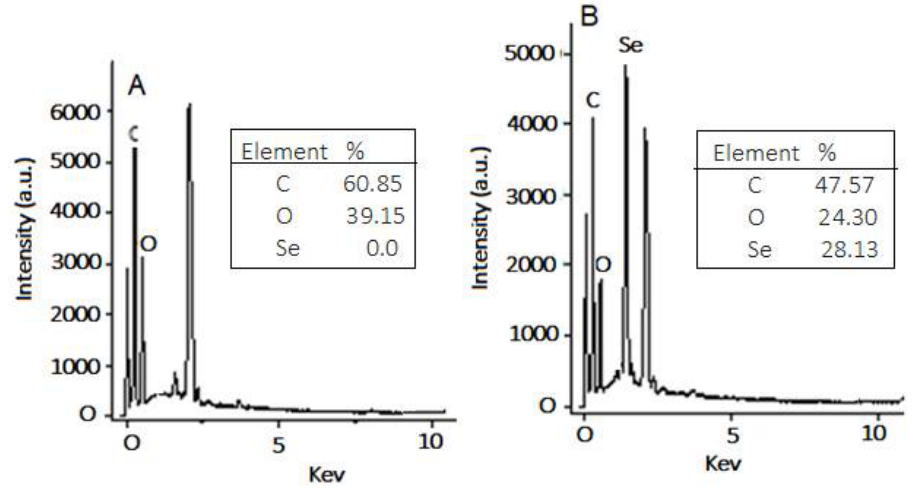
Figure 8. EDX analyses of COO extract ( A ) and GA-COO-SeNPs ( B ).